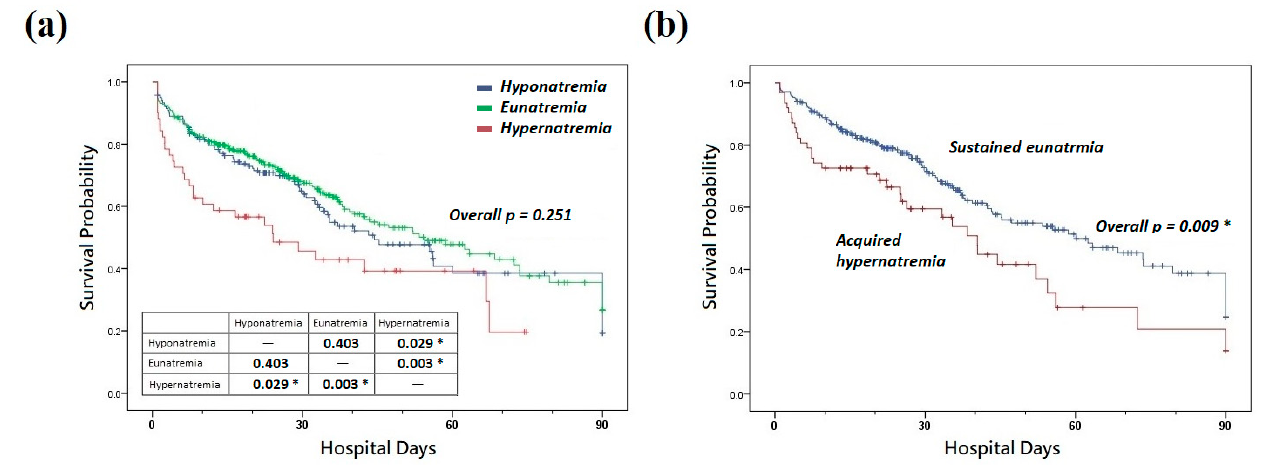
Figure 2. Kaplan–Meier survival curves for ( a ) patients with hyponatremia, eunatremia, and hyper- natremia and ( b ) patients with sustained eunatremia and acquired hypernatremia. * p < 0.05. Table 3. Multivariate binary regression analysis for hospital mortality risk